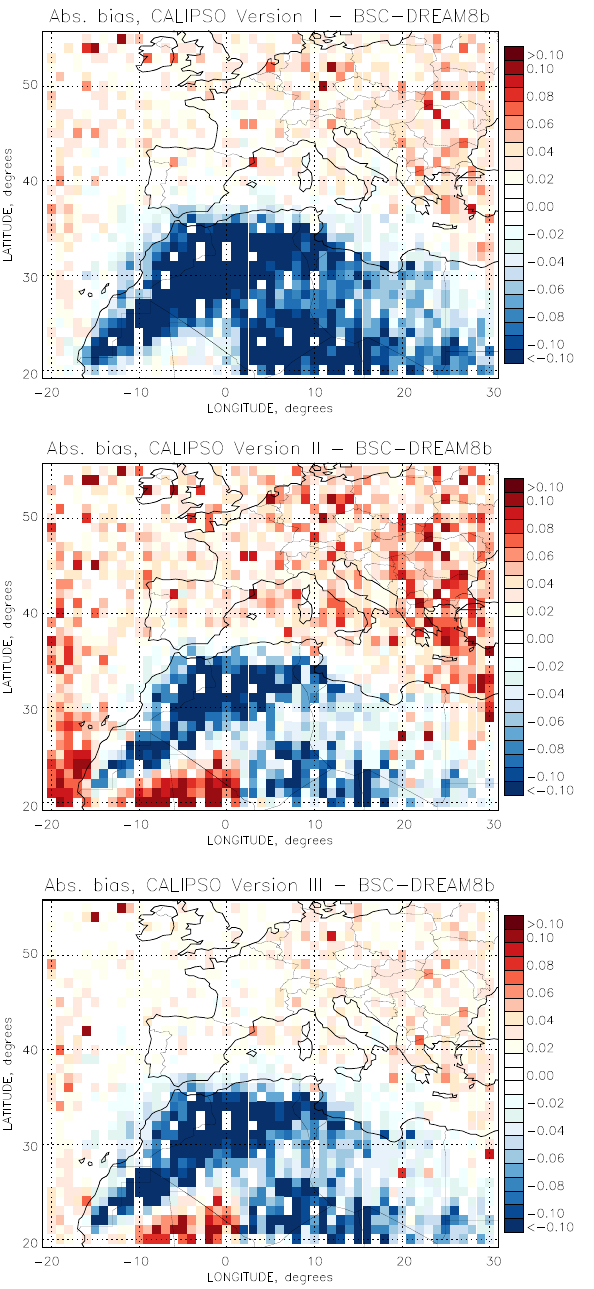
Fig. 10. Spatial distribution of 5yr AOD absolute biases for the three versions of CALIPSO climatological product and the BSC- DREAM8b dust model outputs.